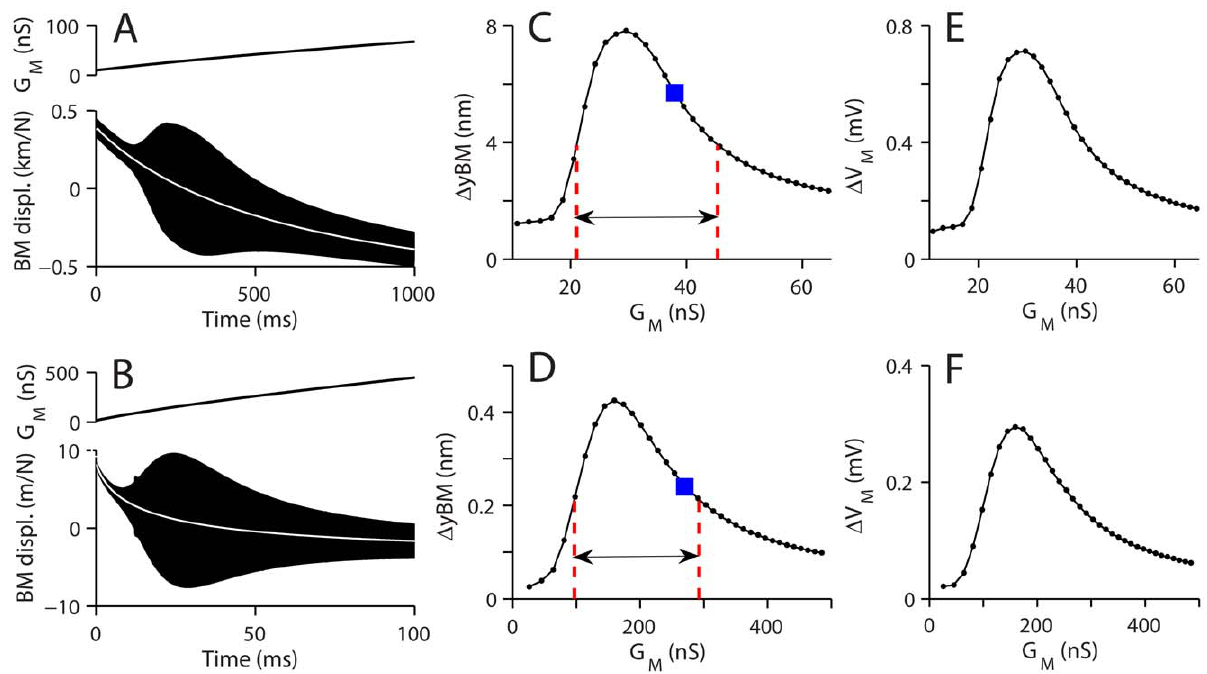
Figure 6. Optimal OHC membrane conductance to amplify basilar membrane vibrations. The basolateral membrane conductance of the OHCs was increased along time axis, while pure tone stimulation was applied. ( A ) The apical section was stimulated with 0.6 kHz 20 pN amplitude force applied at the basilar membrane. During 1000 ms simulation period, the OHC membrane conductance was increased linearly with time from 10 nS to 70 nS (upper plot) and the basilar membrane displacement normalized with the force amplitude was plotted (bottom plot). The stationary position of the basilar membrane (white line) decreased as the membrane conductance increased. ( B ) The basal section was stimulated with 19.5 kHz 50 pN force. During 110 ms simulation period (100 ms shown), the OHC membrane conductance was increased from 30 nS to 480 nS (upper plot). The normalized basilar membrane vibration was plotted (bottom plot). ( C ) Basilar membrane vibration amplitude versus OHC membrane conductance ( G M ), apex. Two vertical broken lines indicate 3 dB bandwidth of the G M . Filled squares ( & ) indicate the response with the G M value used in this study. ( D ) Basilar membrane vibration amplitude versus G M , base. ( E ) Receptor potential versus G M . ( F ) Receptor potential versus G M ,